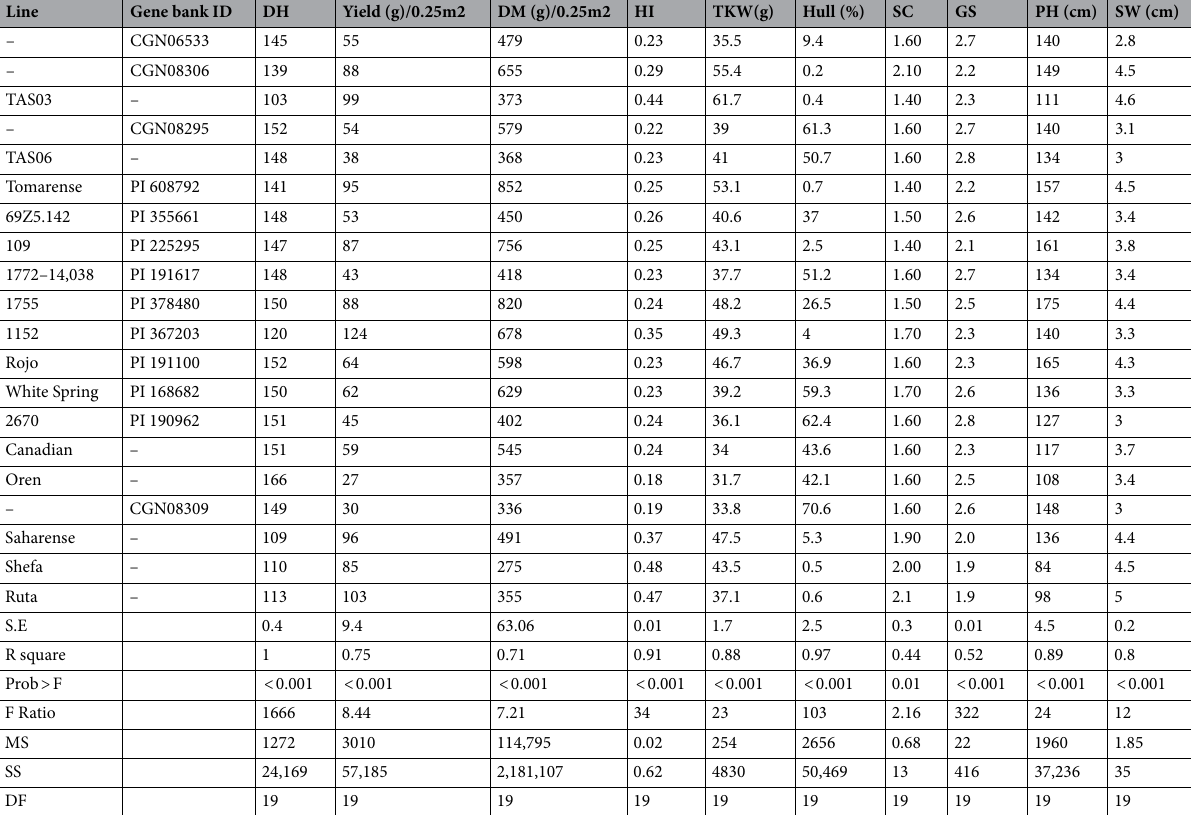
Table 1. Mean data from the 20 lines grown in replicates experiment 2016–17 Bet-Dagan, Israel. Days to heading (DH), Yield (g), Dry matter (DM), harvest index (HI), thousand kernel weight (TKW),